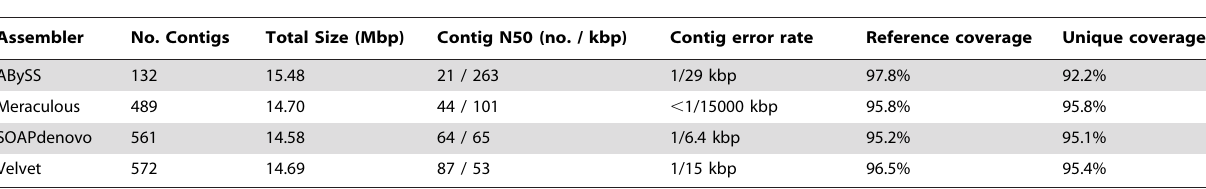
Table 3. Comparison of P. Stipitis assembly contig characteristics (including contigs of at least 100 bp).